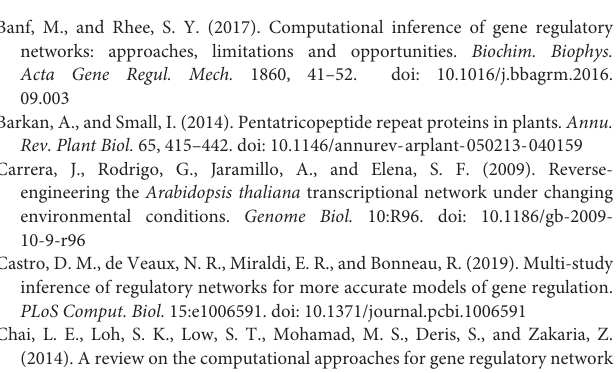
FIGURE S3 | Comparative analysis of four different correlation methods based on connectivity between different functional categories in mitochondria. Using newly updated MapMan annotations (MapMan X4 Release 1.0, 2018; Usadel et al., 2009), the mitochondrial set was subdivided into 29 different functional categories. FIGURE S4 | Synthesis of a conventional co-expression network of Arabidopsis shoots common to four stresses with a CSE Reference Community Set. A core set of stress-responsive genes isolated from non-CSE AtGenExpress stress dataset (Kilian et al., 2007) covering heat, drought, cold, and salt stresses, cross-referenced with the CSE Reference Community.